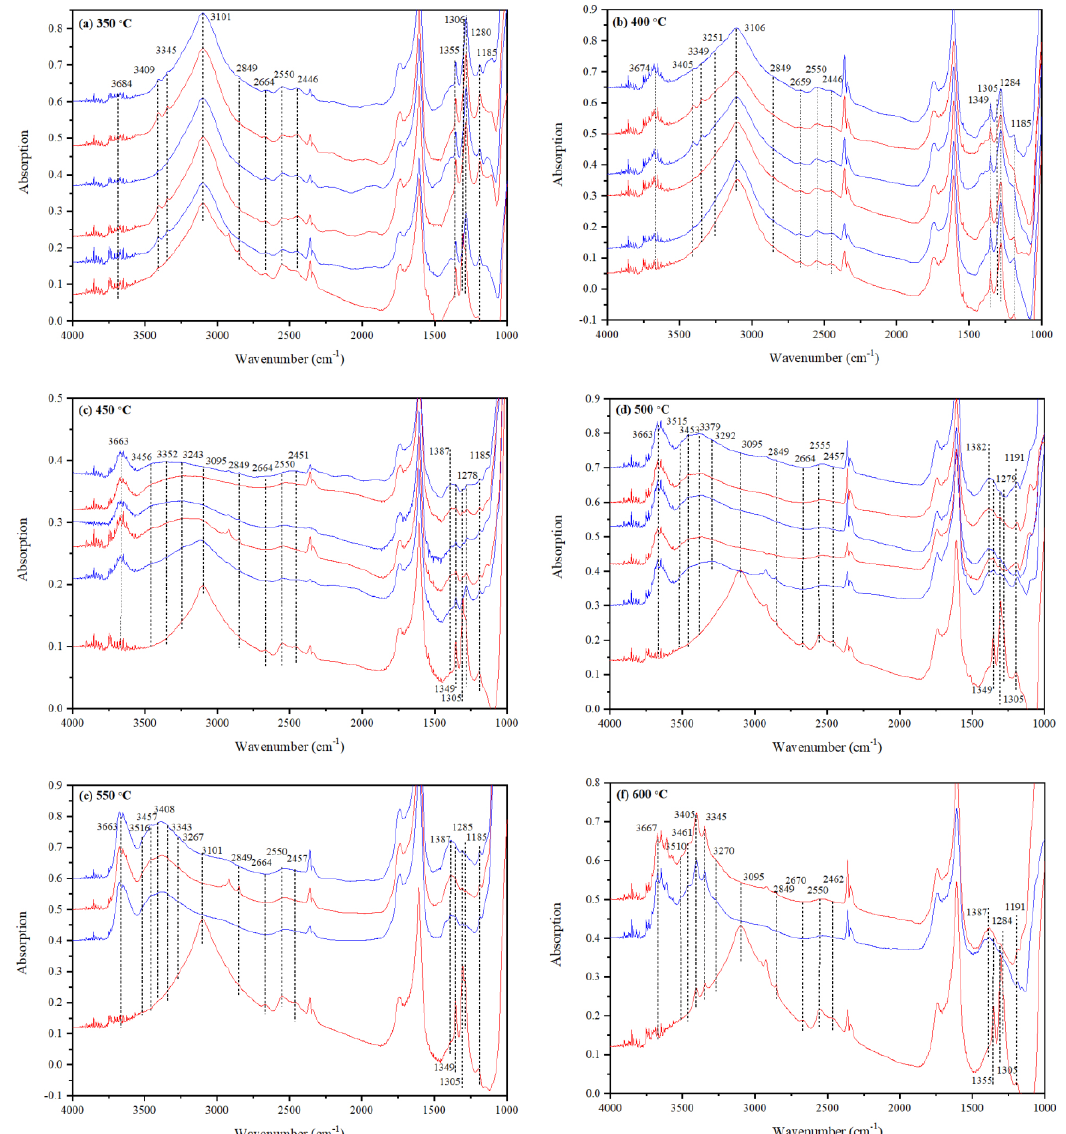
Figure 10. Unpolarized IR spectra (4000–1000 cm − 1 ) collected on the thin sections: ( a ) 1589-01 ( D m = 52 µ m) annealed at 350 ◦ C; ( b ) 1589-02 ( D m = 52 µ m) annealed at 400 ◦ C; ( c ) 1589-03 ( D m = 52 µ m) annealed at 450 ◦ C; ( d ) 1589-04 ( D m = 52 µ m) annealed at 500 ◦ C; ( e ) 1589-05 ( D m = 63 µ m) annealed at 550 ◦ C; ( f ) 1589-06 ( D m = 69 µ m) annealed at 600 ◦ C. For the purpose of comparison, the IR